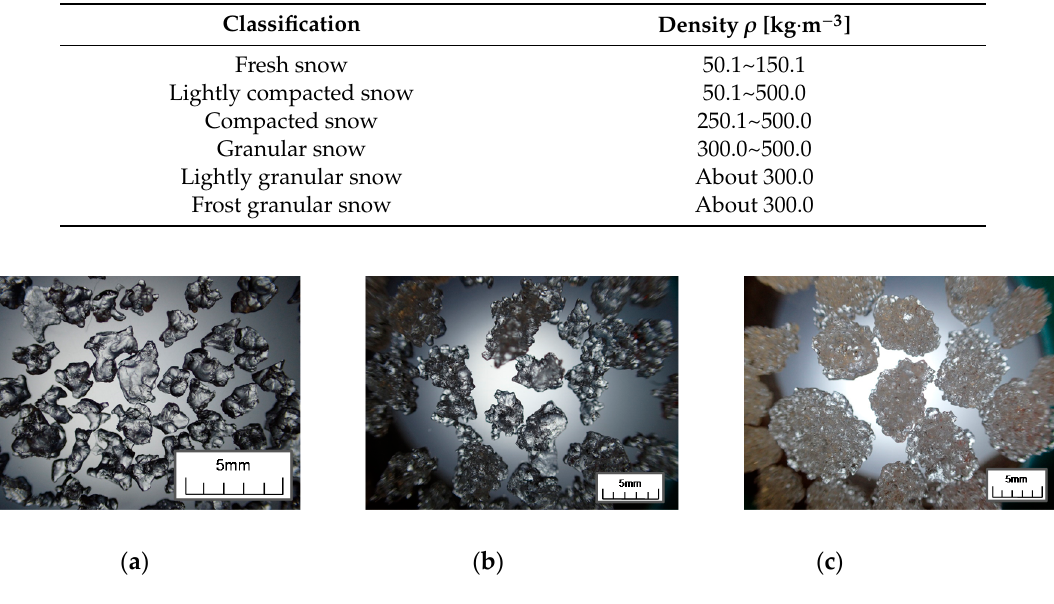
Figure 2. Particle image of the adjusted snow: ( a ) particle size is 1 mm; ( b ) particle size is 2 mm; ( c ) particle size is 4 mm. Table 1. Classification of snow quality according to the density of the snow [19].